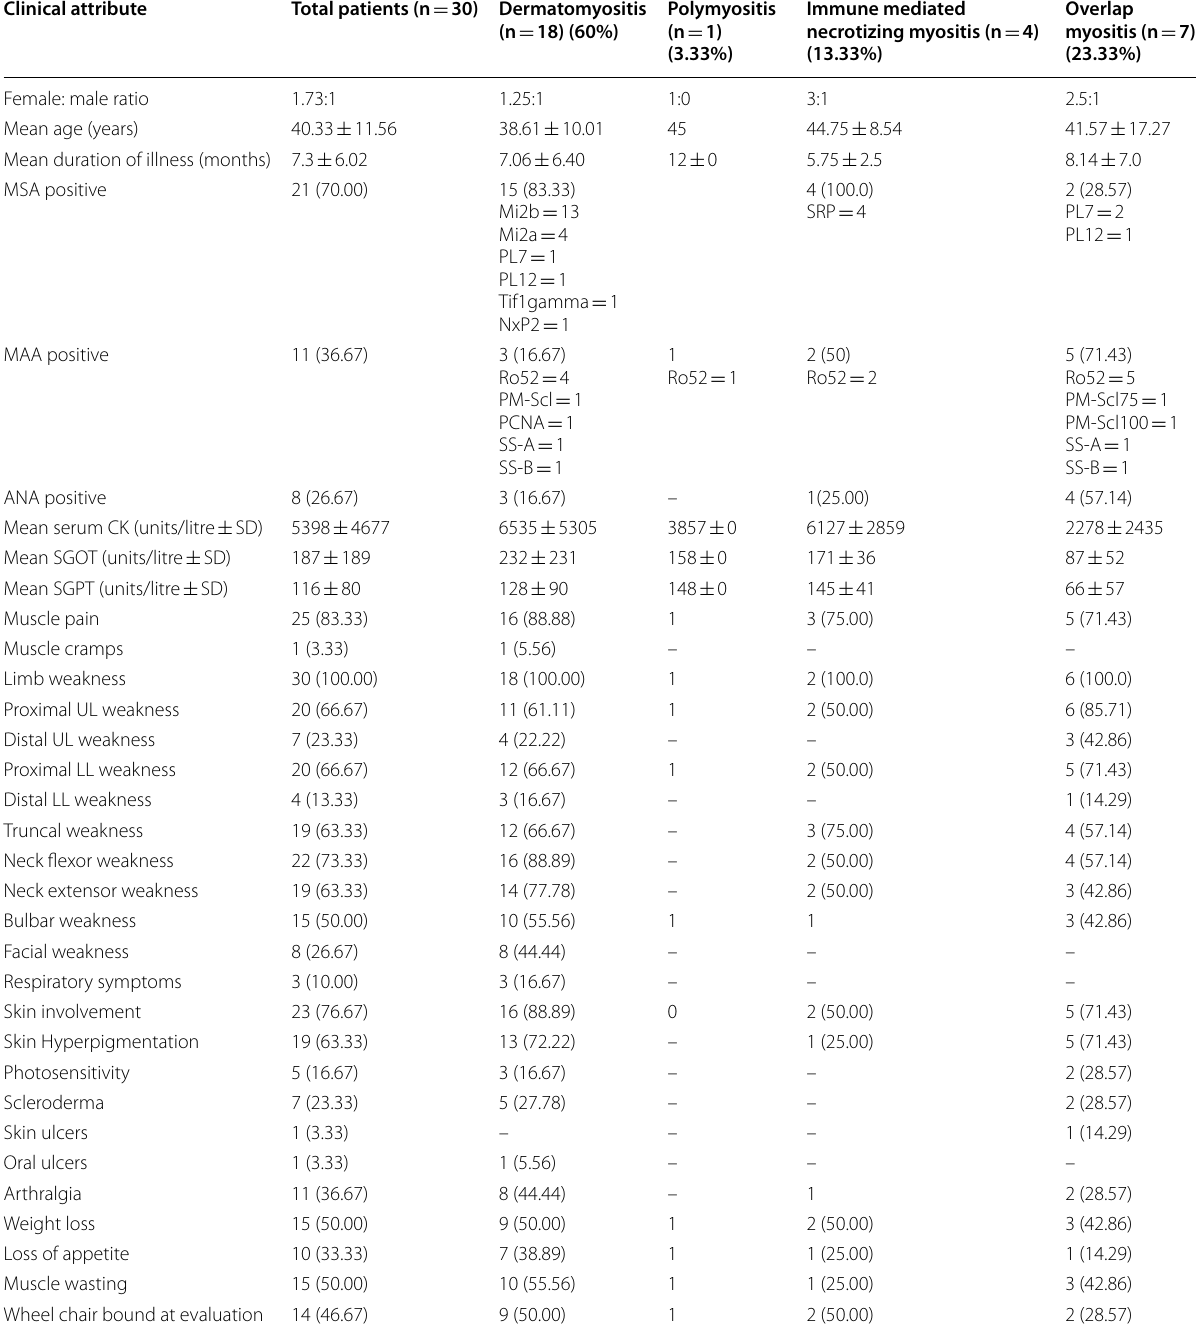
Table 1 Patient characteristics for subcategories of inflammatory